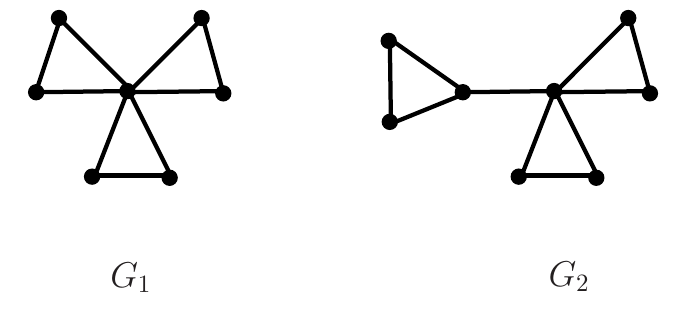
Figure 2: Two counterexamples of Conjecture